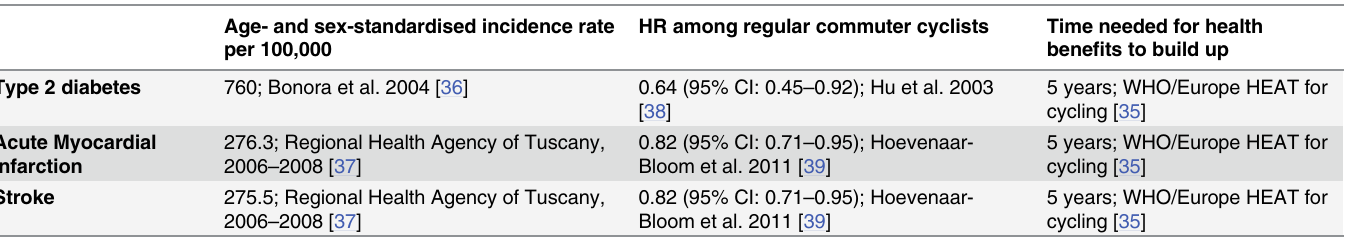
Table 1. Cycling and NCD prevention data.